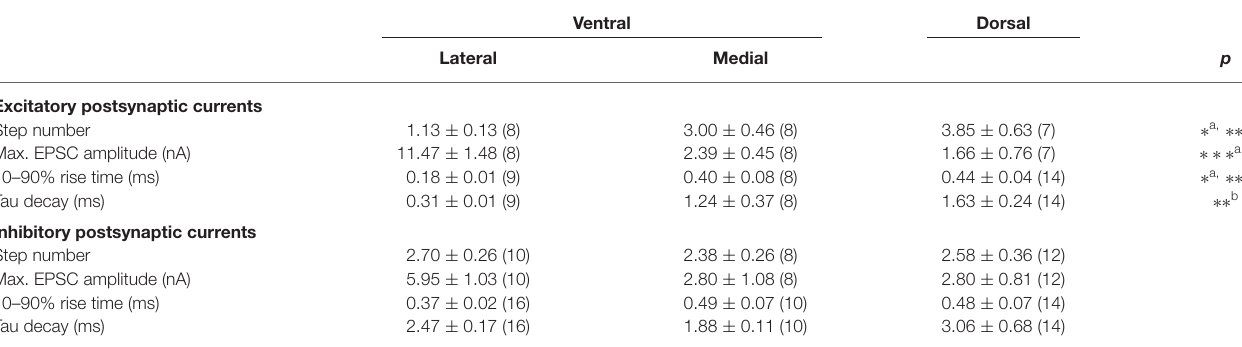
TABLE 2 | Summary of synaptic properties of dVNLL and vVNLL